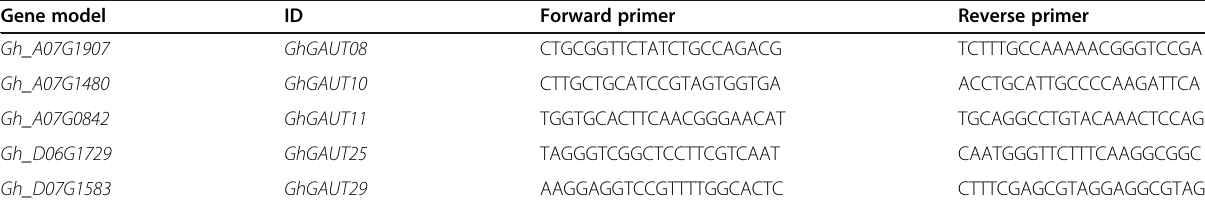
Table 6 Details of primers for quantitative real-time PCR Gene